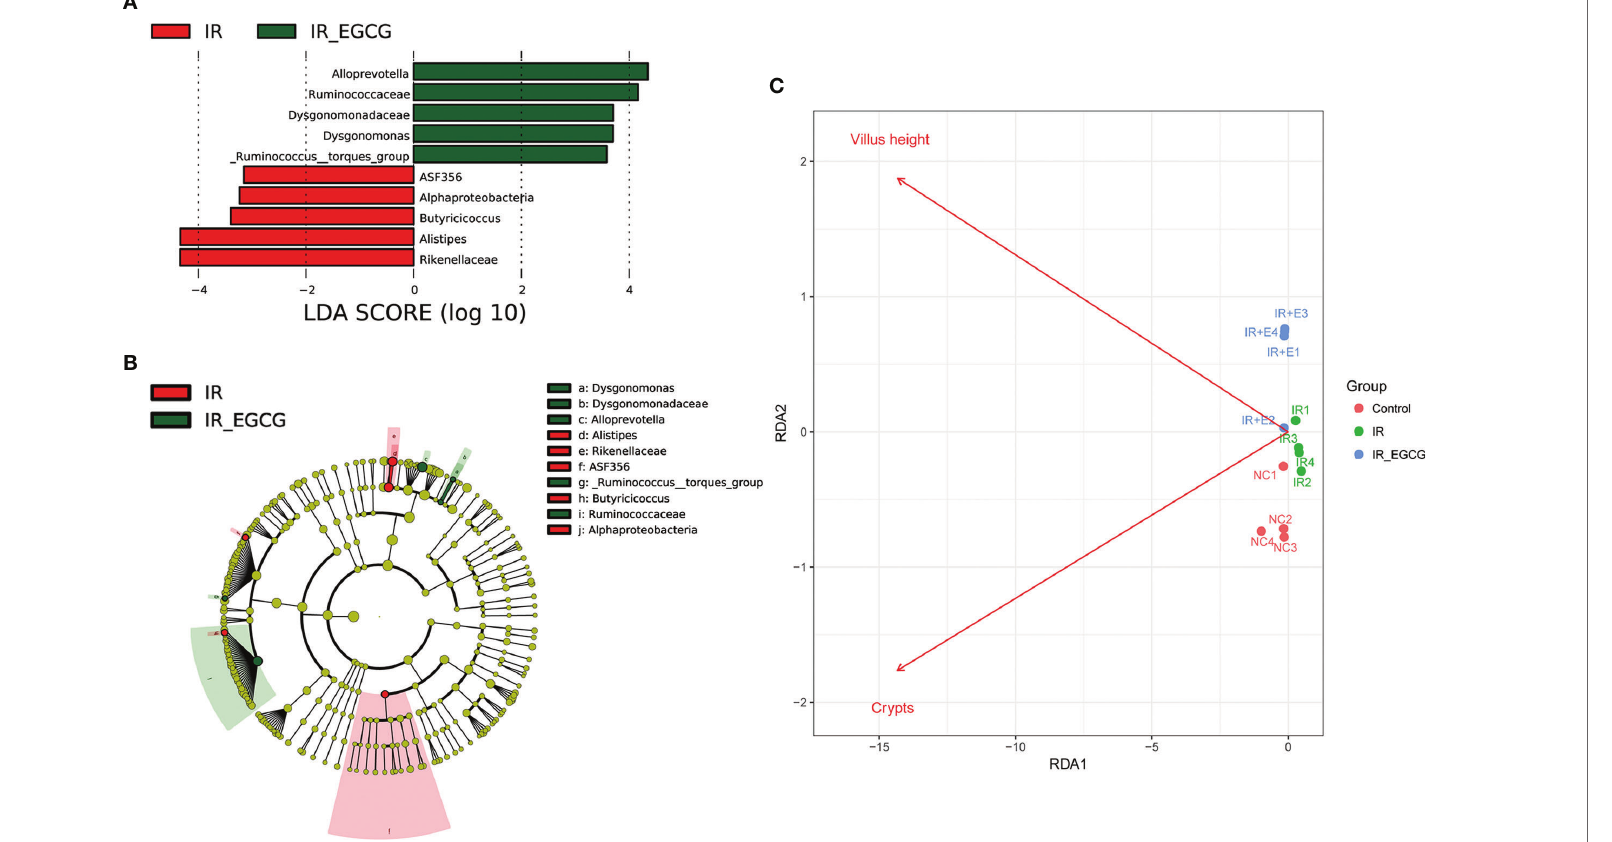
FIGURE 7 | Gut microbiota alterations correlated with TBI-induced intestinal injury. (A) Histogram showing the LDA scores indicative of differentially abundant bacteria between the IR (red) and IR + EGCG (green) groups (n = 4). Characteristic taxonomies with LDA scores > 3.5 are shown. (B) LEfSe cladogram showing the most differentially abundant taxa between the two groups. The taxa enriched in the IR and IR + EGCG groups are shown in red and green, respectively. The brightness of each dot is proportional to its effect size. (C) Redundancy analysis (RDA) of the microbial community structure based on 16S rRNA gene sequencing data. The length of the arrows corresponds to the in fl uence of the indicated environmental parameter on the microbial